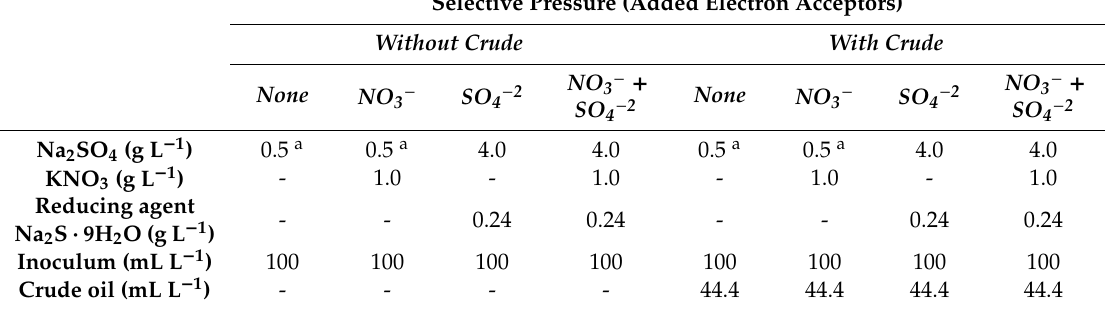
Table 4. Supplements used in cultures prepared with deep-sea sediments according to the di ff erent selective factors (in italics).